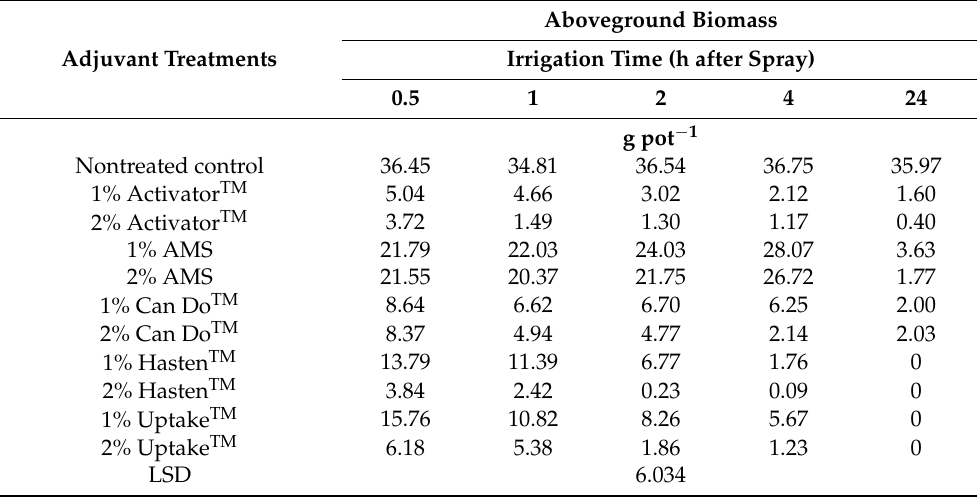
Table 8. The interaction effect of adjuvant treatments and irrigation time after herbicide application on the biomass of Navua sedge when halosulfuron-methyl at 49 g ha − 1 (mixed with different adjuvants) sprayed on 8–10 cm tall plants (10–12 leaf stage). Aboveground Adjuvant Treatments